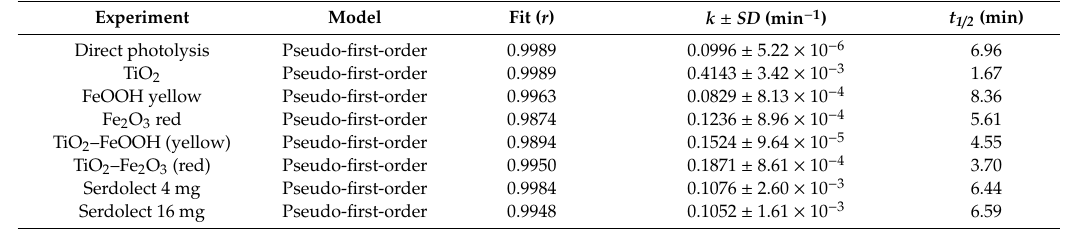
Table 2. Summary of sertindole degradation kinetics